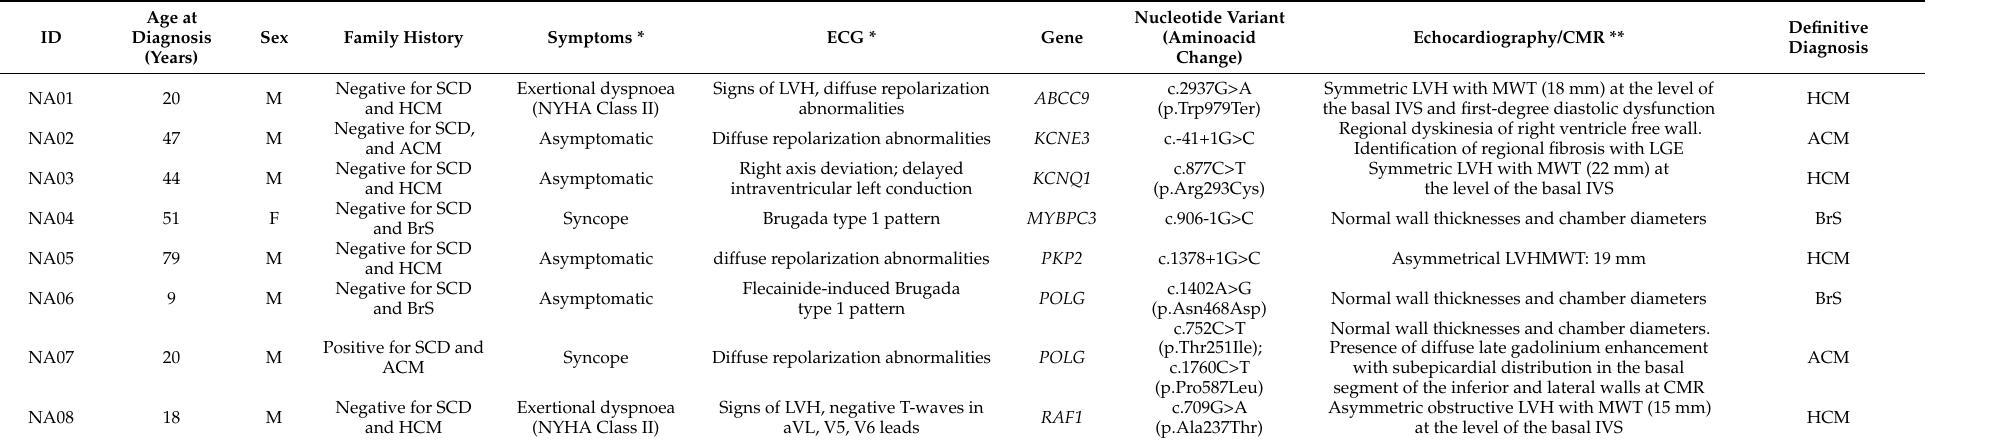
Table 2. Demographic, clinical, and instrumental data of patients carrying pathogenic or likely pathogenic variants in uncommon genes with respect to the clinical diagnosis or suspicion of an inherited cardiac disease (cardiomyopathy or